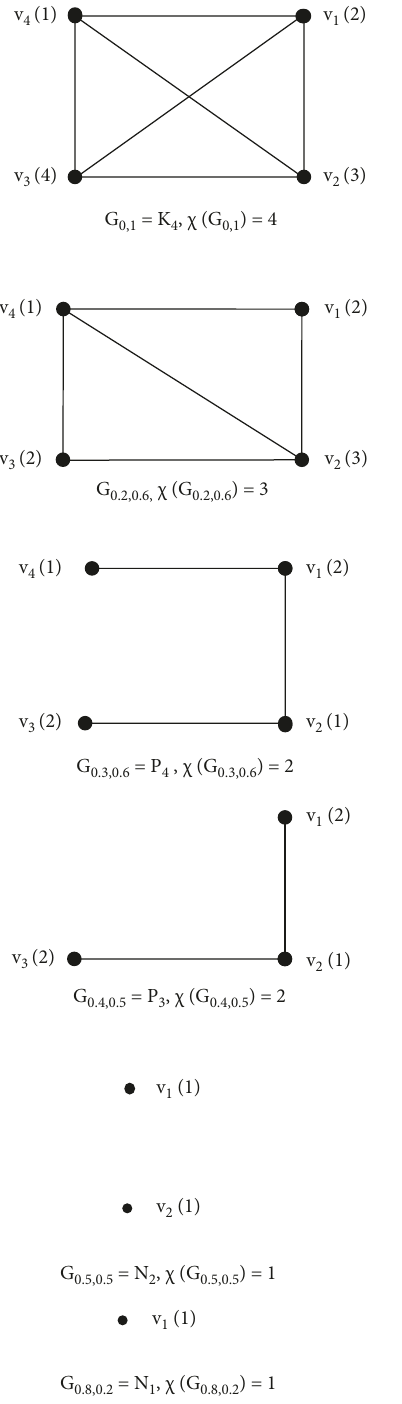
Figure 2: Illustration on the G with their chromatic numbers.